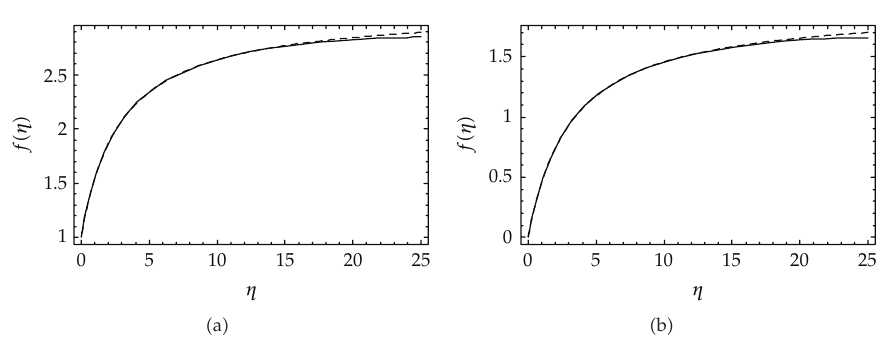
Figure 4: Profiles of the similar stream function f (cid:3) η (cid:4) as a function of η at m (cid:8) 0 for (cid:3) a (cid:4) s (cid:8) 1 , λ (cid:8) 0 . 5 and (cid:3) b (cid:4) s (cid:8) 0 , λ (cid:8) 1, solid and dashed lines are for ChPDM and G (cid:2) /G -expansion solutions,